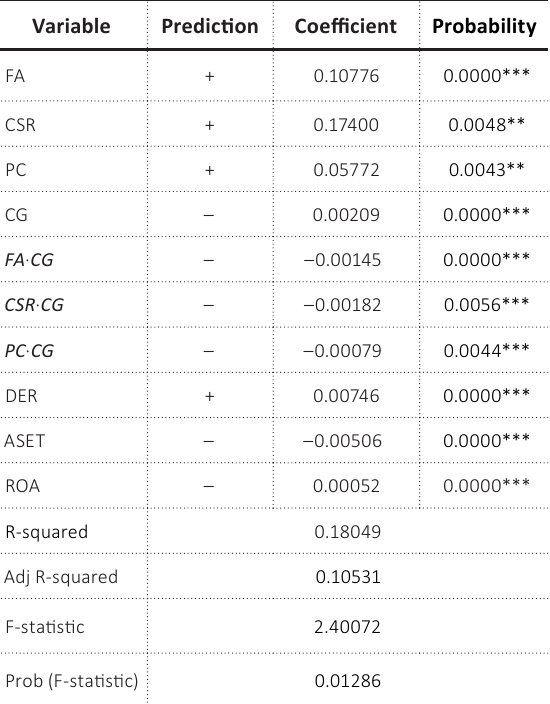
Table 2. Regression results for Model